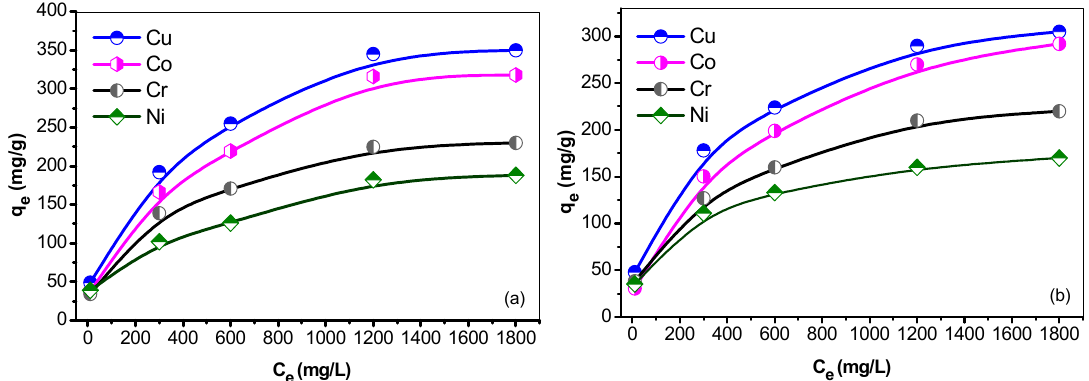
Figure 11. The influent of initial concentration of metal ions in solution on the adsorption of metal by the jute cellulose-based polymer ligands: ( a ) PHA and ( b ) PA ligand; experimental variables: 0.5 g of ligands (PHA or PA), 15 mL of distilled water, 5 mL of pH 6 buffer solution, 5 mL of 0.2 M synthetic metals ions solution and stirred for 2 h.